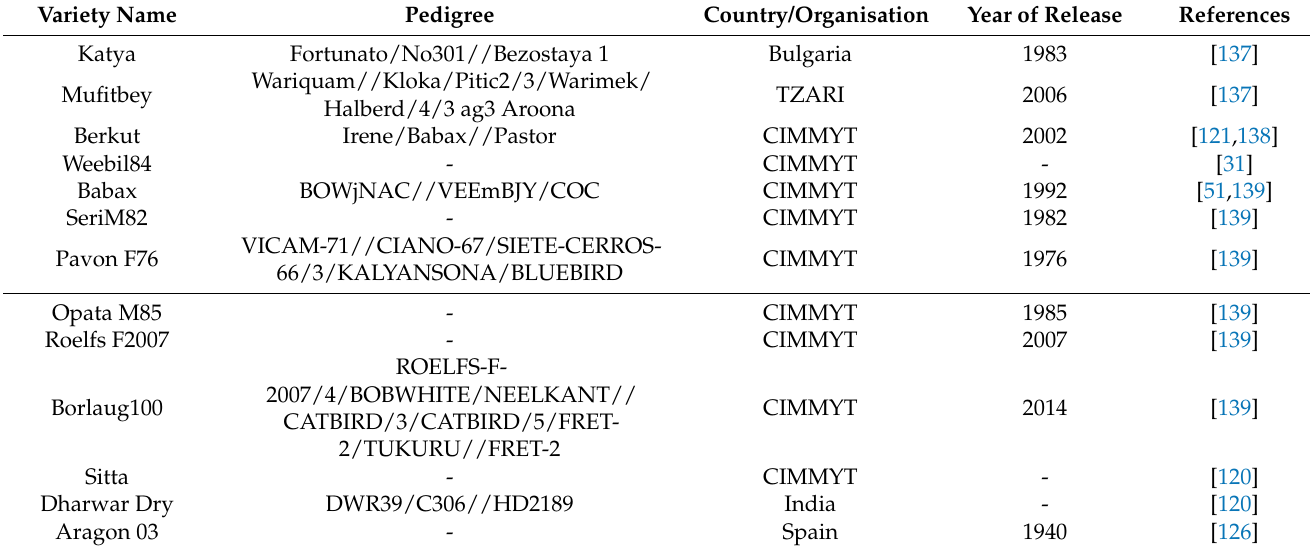
Table 3. Some of the drought-tolerant wheat genetic sources reported